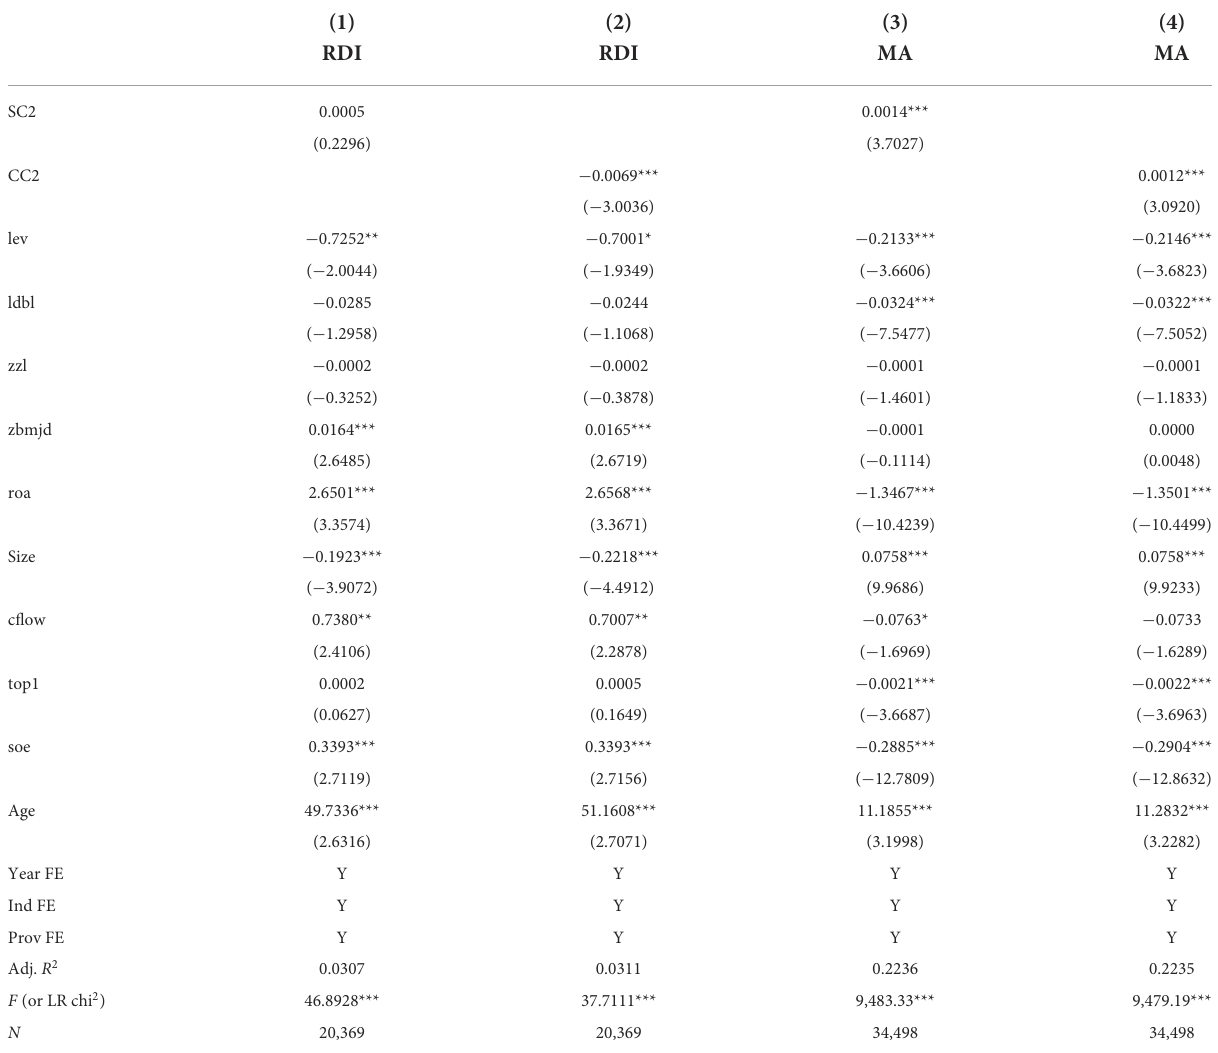
TABLE 11 Supply chain concentration, R&D investment, and M&A